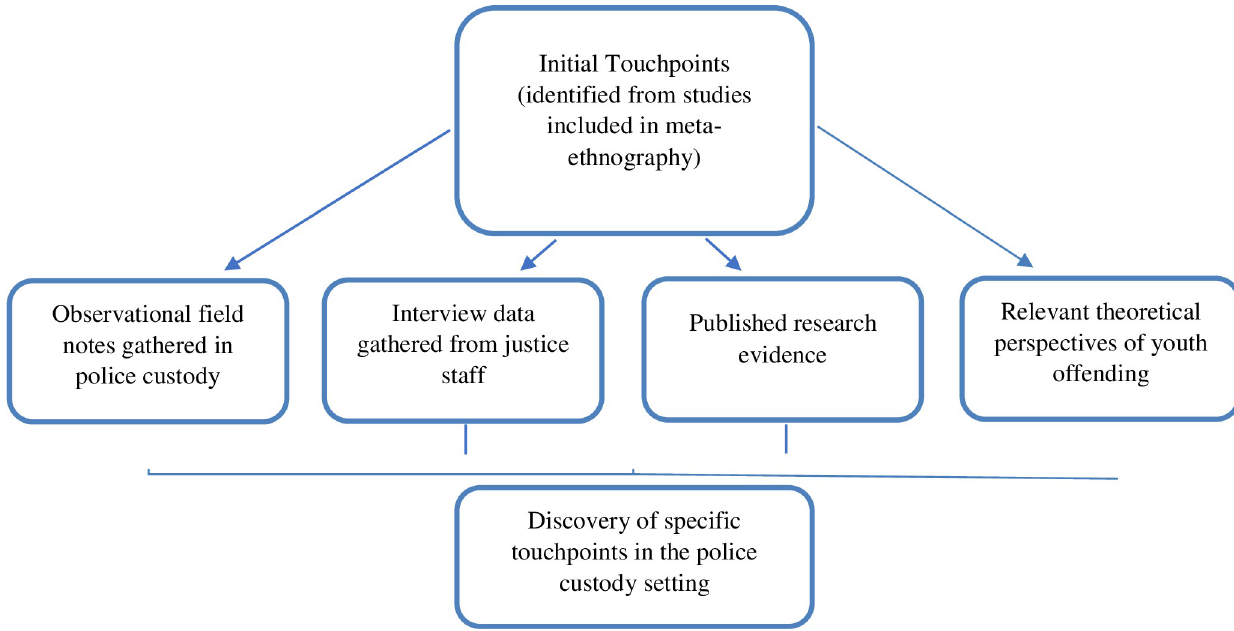
Fig 2. Modified process for developing touchpoints for young people who